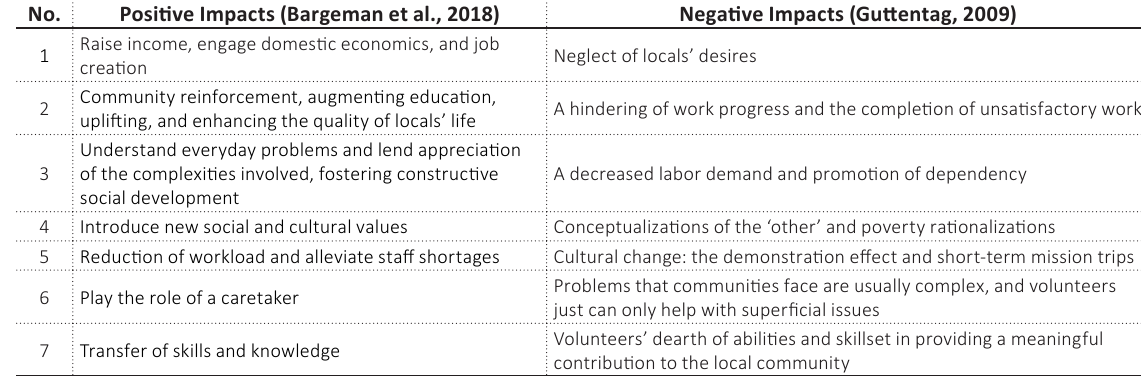
Table 1. Overview of impacts